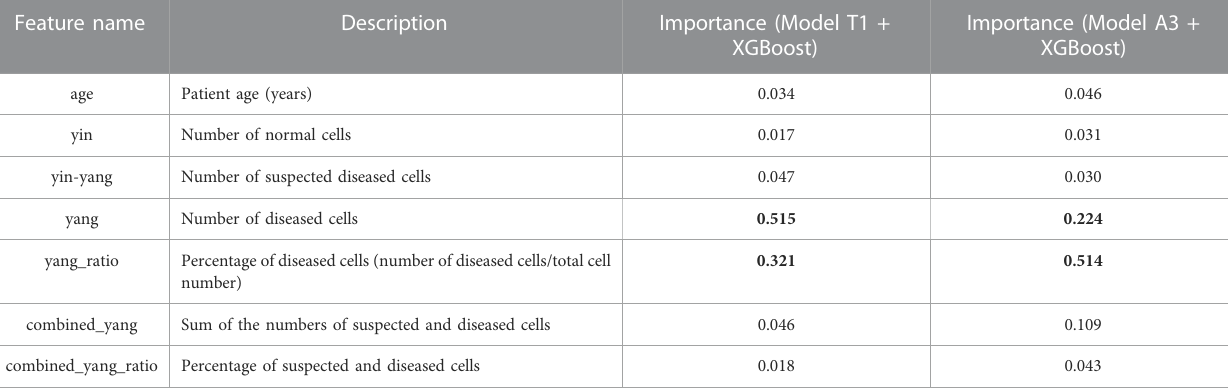
TABLE 6 Features used for training the patient diagnosis models and their importance.